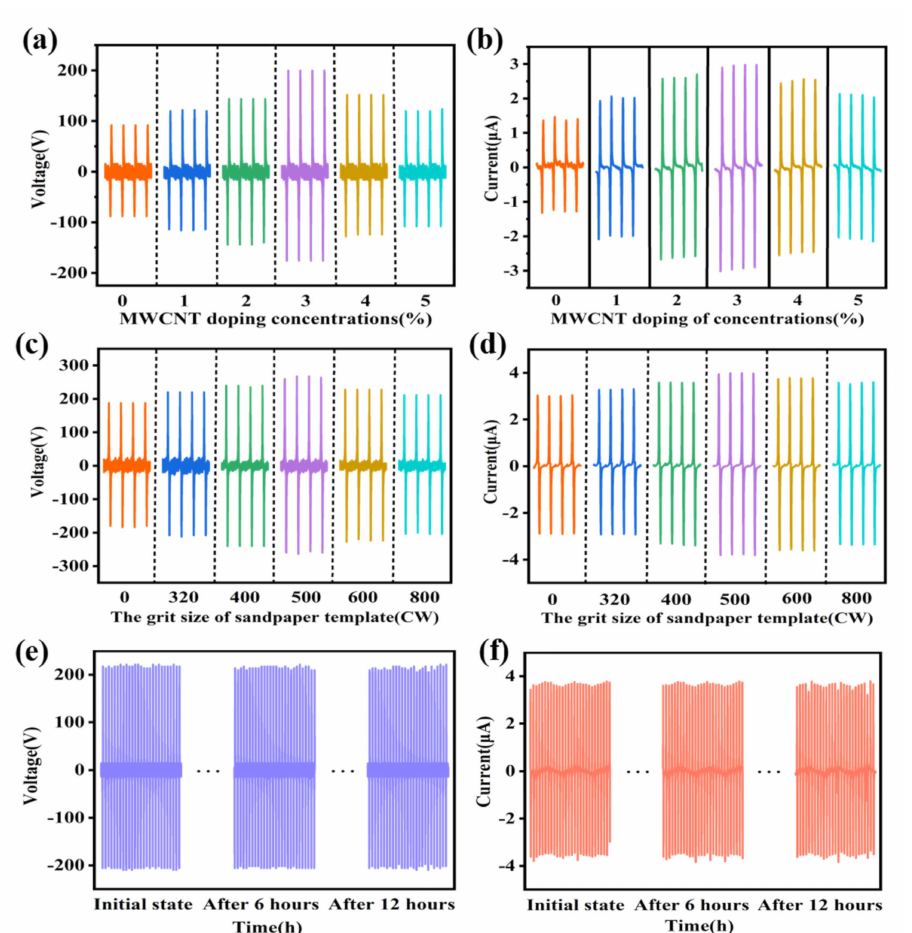
Figure 5. Output performance of modified silicone rubber: the ( a ) Voc and ( b ) Isc of TENG under different doping concentrations; the ( c ) Voc and ( d ) Isc of TENG under different sandpaper template grit sizes; ( e , f ) the durability and stability of modified silicone rubber. The output voltage of the TENG is obtained using an MSO oscilloscope, and the horizontal scanning time is set as 4 s per